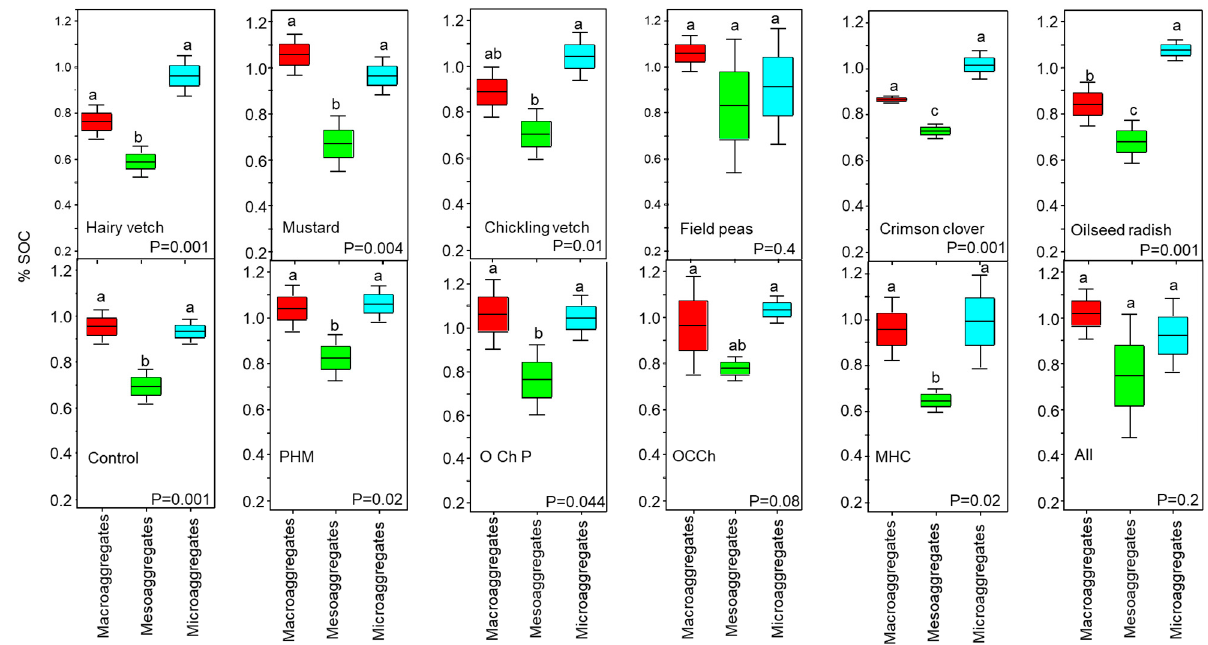
Figure 4. The OC contents of different soil aggregate-size classes under various cover crop treatments. Error bars represent means ± 1SE, and the lack of shared letters above the bars reflects a significant difference.